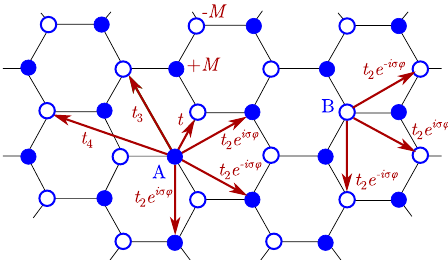
Figure 4: Illustration of the extended Kane-Mele model on the honeycomb lattice with nearest-neighbor hopping t , i -th neighbor hopping amplitudes t on-site potential M . Hopping processes between second neighbors acquire a phase e ± i σϕ depending on the spin σ = ± 1 ≡ ↑ , ↓ of the involved particles, on the hopping direction, and on the sublattice A, B. Red arrows indicate a selection of hopping processes. Other hopping processes can be inferred by